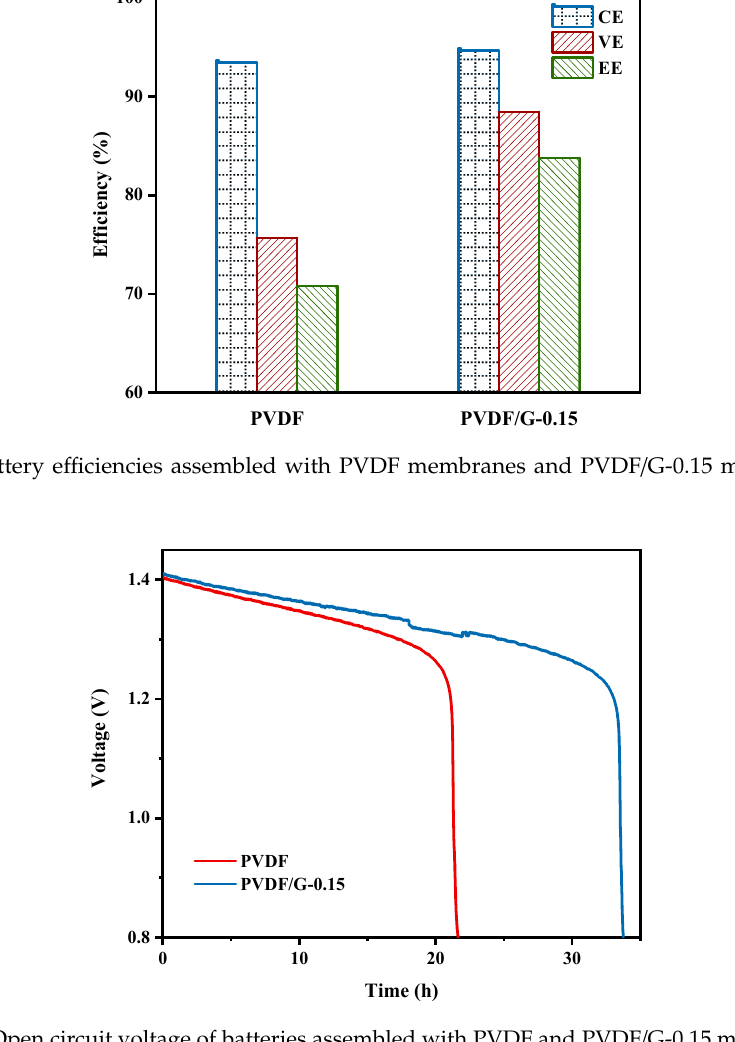
Figure 8. Open circuit voltage of batteries assembled with PVDF and PVDF/G-0.15 membranes.